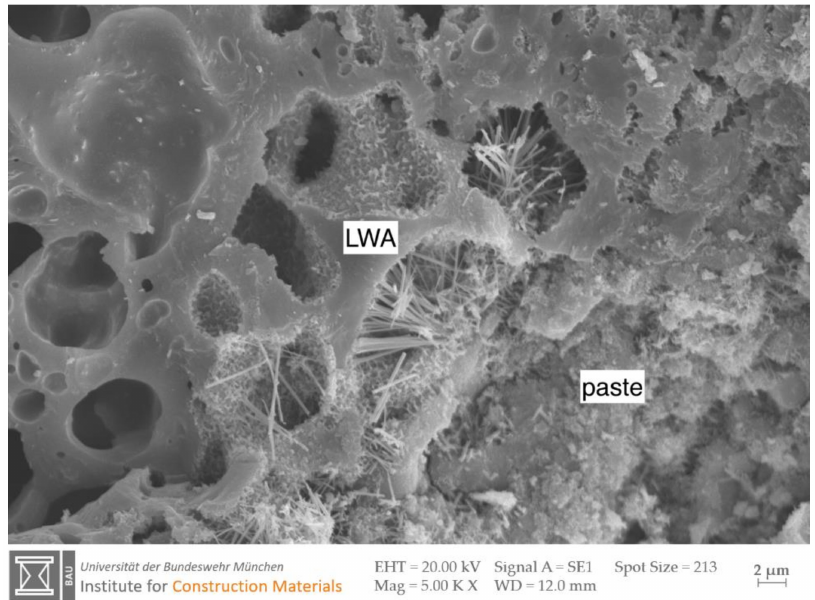
Figure 4. SEM image of the interfacial transition zone in lightweight concrete between an expanded clay aggregate and the paste. Hydration products are visible inside the outer LWA pores